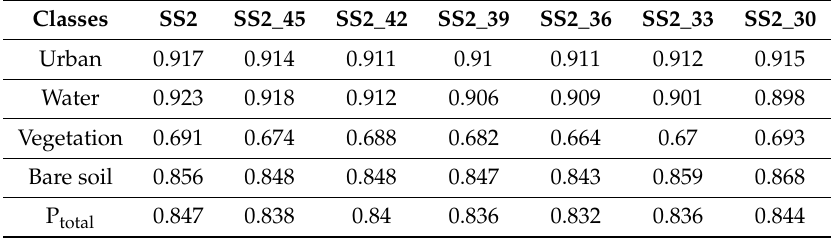
Table 30. Probabilities of correct classification depending on compressed image quality for Set 2, ADCTC coder, ML